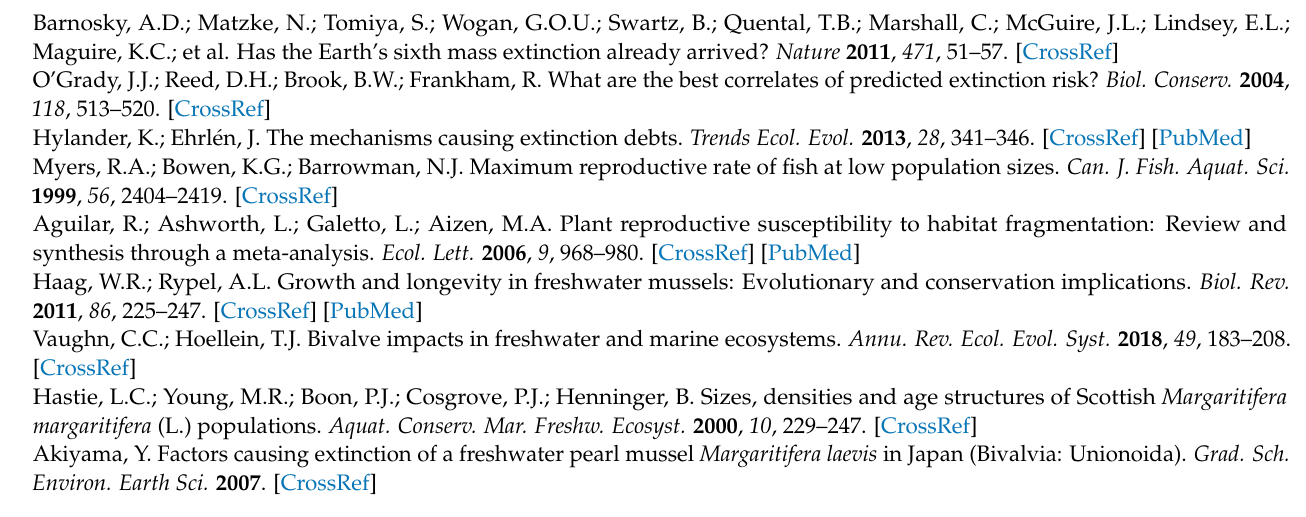
Figure S2: Relationship between the index of nutrient enrichment and proportion of farmland, Table S1: Abiotic and biotic factors used in the statistical analysis, Table S2: Host fish density in the study streams (A–J) from 2005 to 2016, Table S3: Results of preliminary analysis (GLMMs) for selecting explanatory variables from the host fish density and the index of nutrient enrichment, Table S4: Results of the estimations of four nonlinear growth models in the three regions, Table S5: Results from the GLMs examining the abiotic factors affecting the host fish density in ascending order of